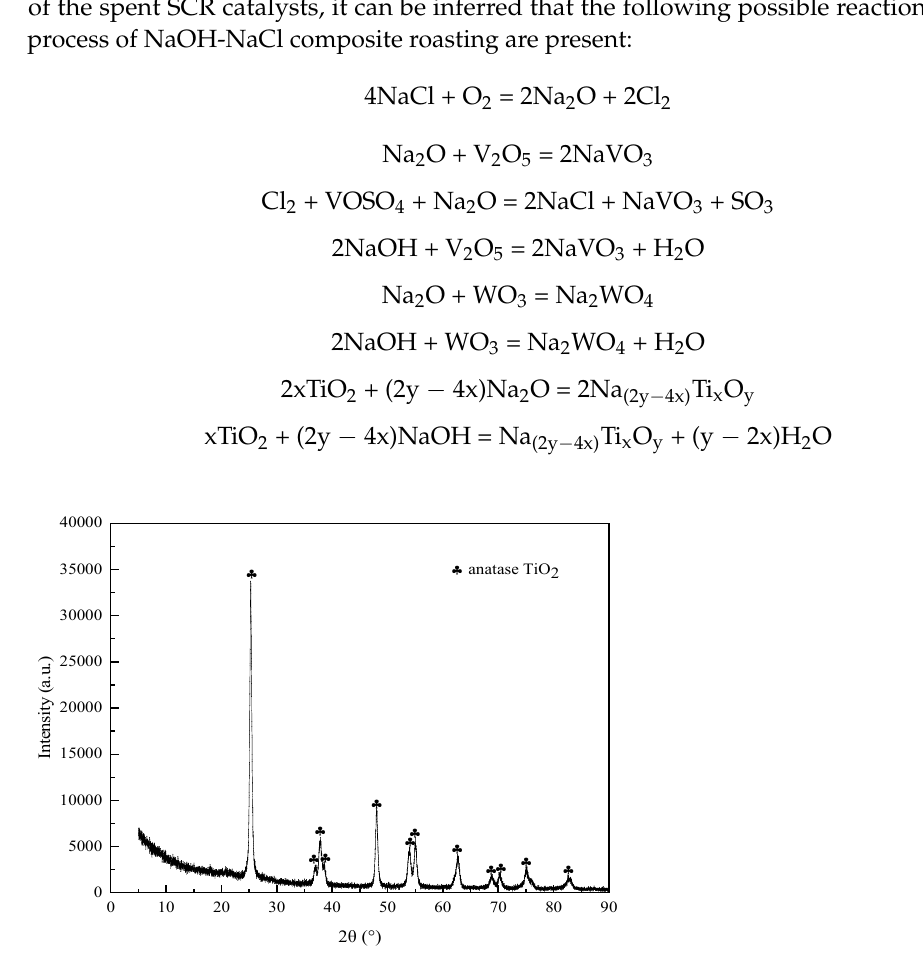
Figure 2. The XRD spectra of spent SCR catalysts. Table 1. Chemical composition of fresh and spent SCR catalysts. Composition TiO 2 Others Content (wt.%)